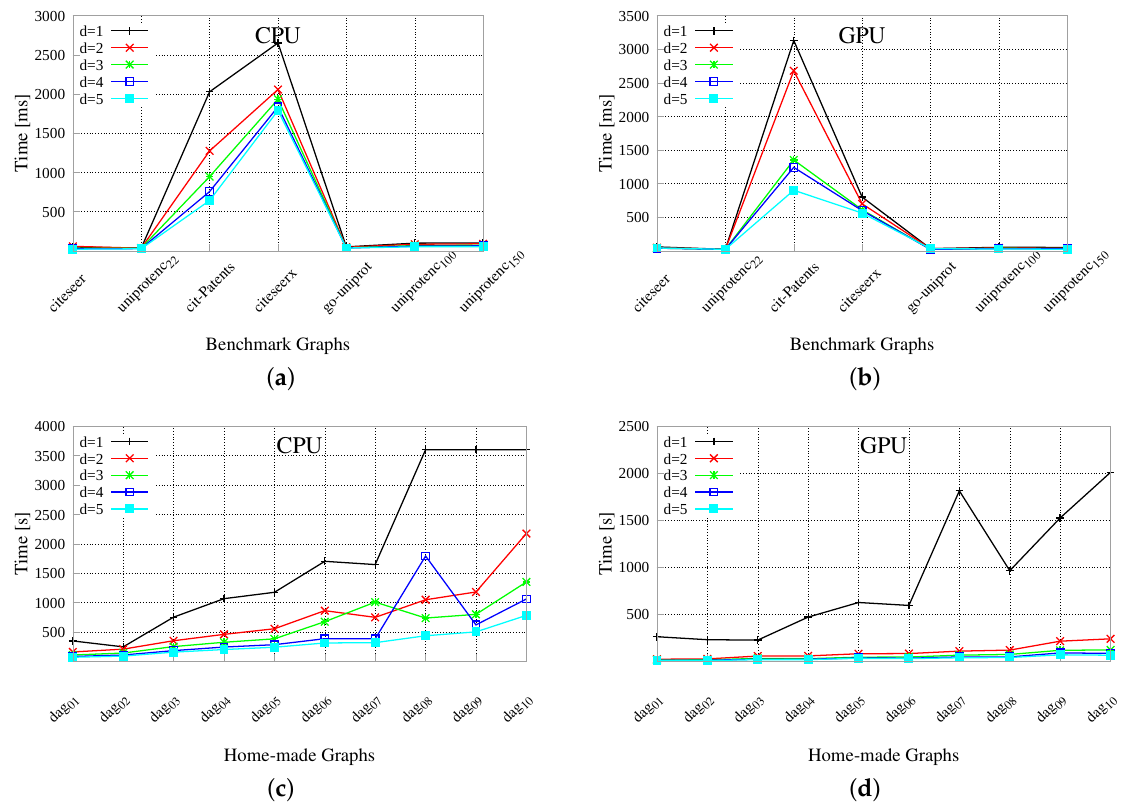
Figure 6. Query results on benchmark and home-made graphs. The labeling times are reported in milli-seconds, for different labeling size (from d = 1 to d = 5), Plots ( a , c ) reports the time for the original GRAIL implementation; plots ( b , d ) the ones for the GPU-based version. A value equal to 3600 s (1 h) corresponds to a time